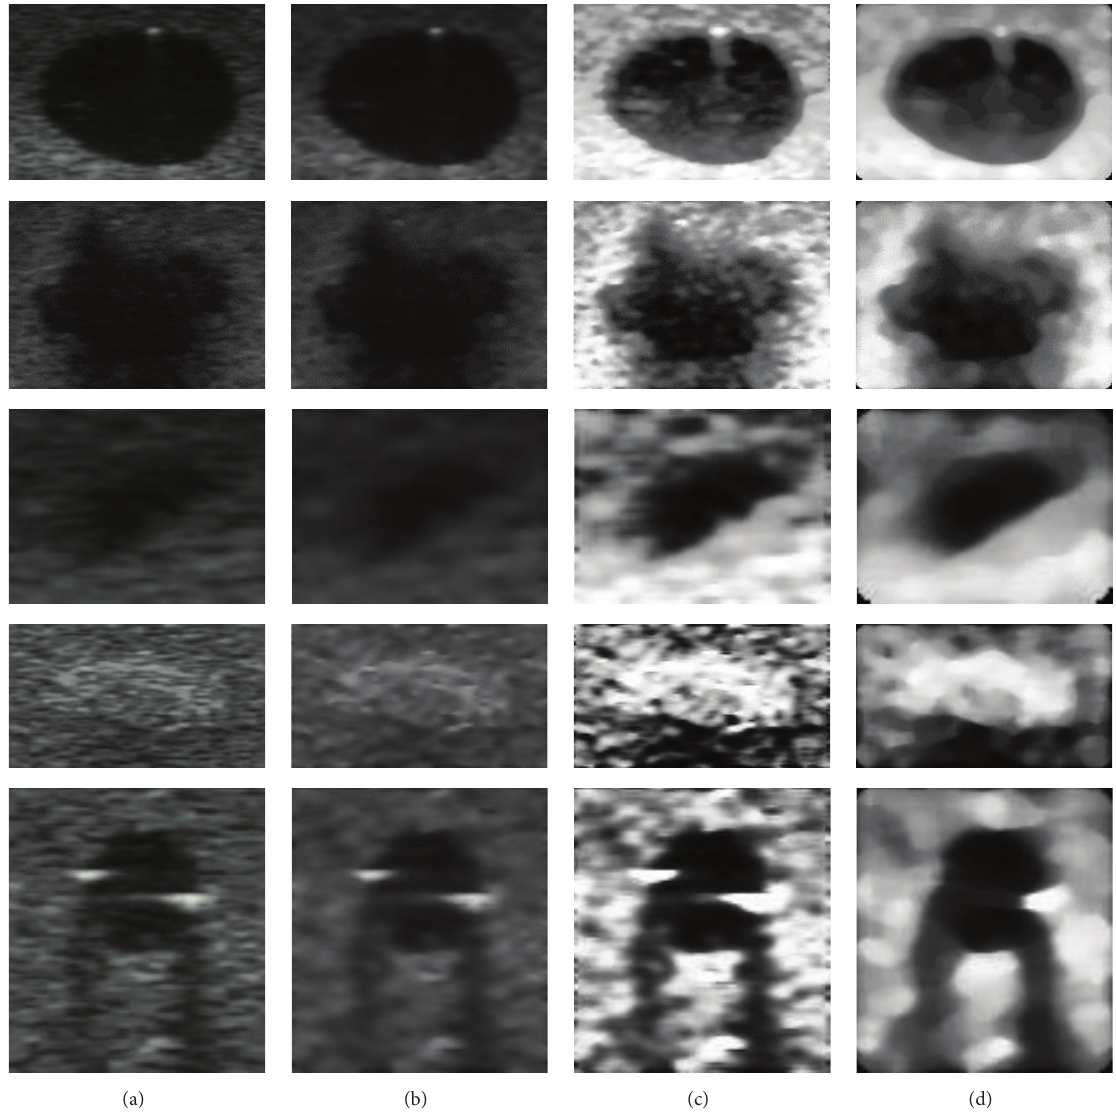
Figure 5: ROIs from breast phantom images: (a) original image; (b) after Wiener filtering; (c) with equalization; and (d) after being submitted to a median